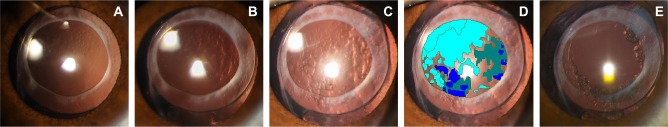
Evolution of pearl-type PCO in one eye that required treatment (A: three; B: six; and C and D: twelve months postoperatively. The opacification areas (D) were color coded according to their densities in the EPCO software (0: no color; I: light blue; II: intermediate blue; III: dark blue, IV: there were none in this case) and (E) after Nd:YAG capsulotomy.